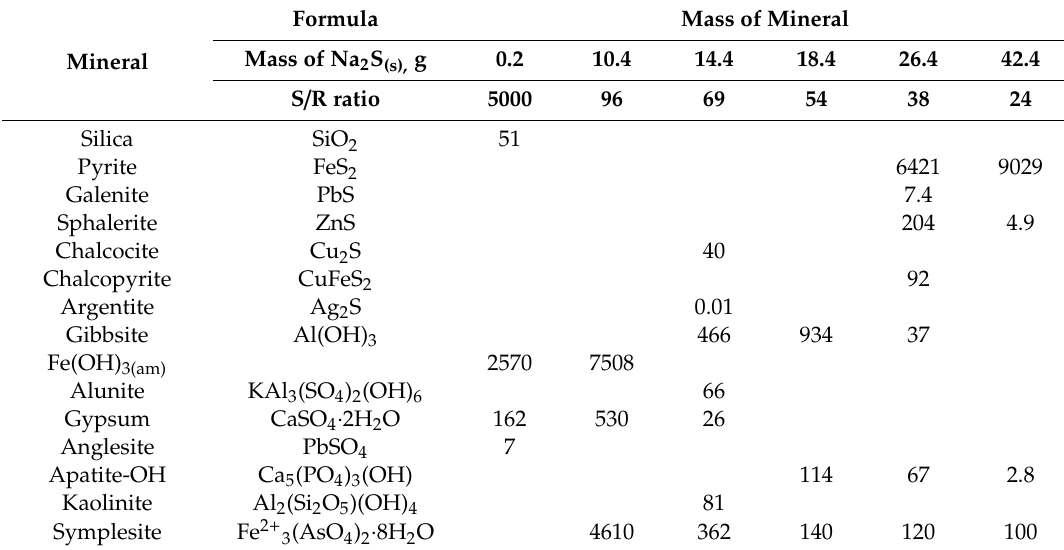
Table 6. Model quantity of precipitated minerals, mg (numerical simulation for Na 2 S